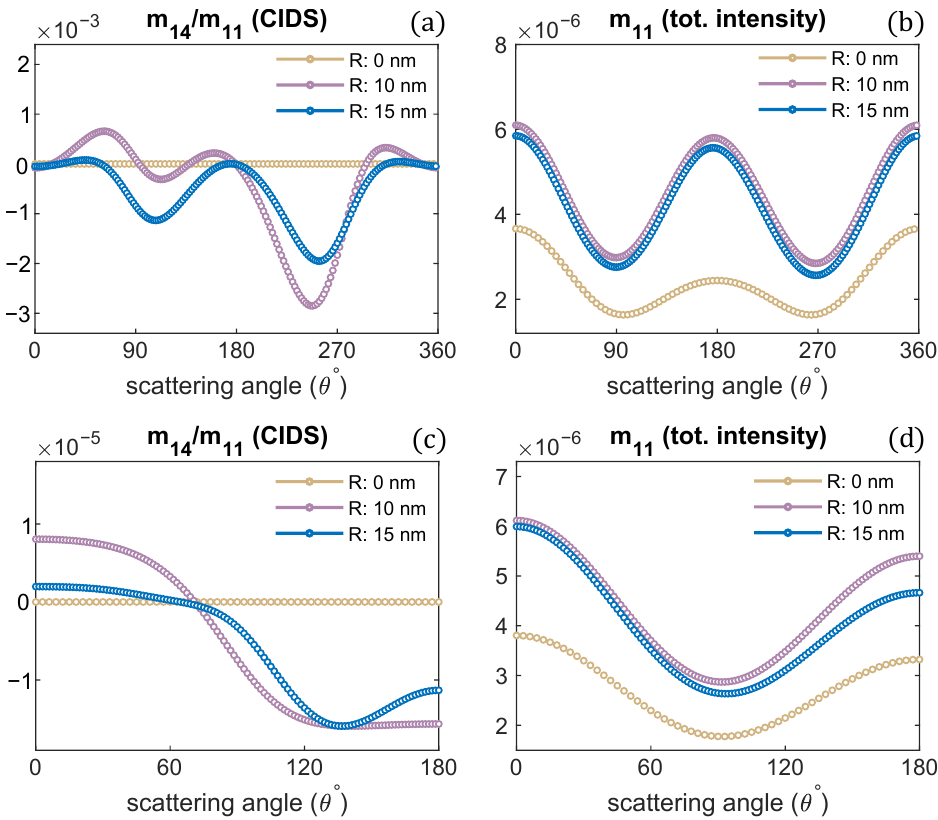
Figure 4. Radius of chromatin fiber is varied, the pitch is kept constant. CIDS and total scattered intensity calculations are presented, respectively; ( a , b ) at fixed orientation, ( c , d ) orientation averaging is perfromed. P = 11 nm, λ = 300